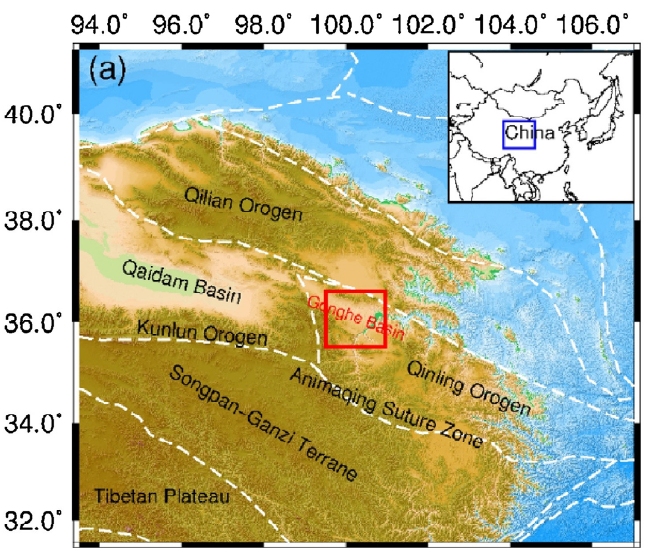
Figure 12. The distribution of major tectonic structures in Gonghe Basin [37].